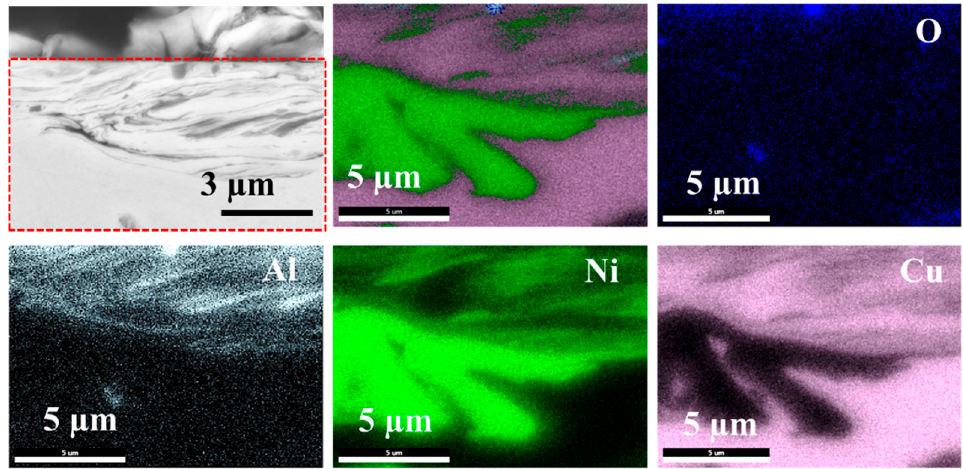
Figure 6. EDS mapping showing the elemental distribution of the FSP ‐ S2 coating.